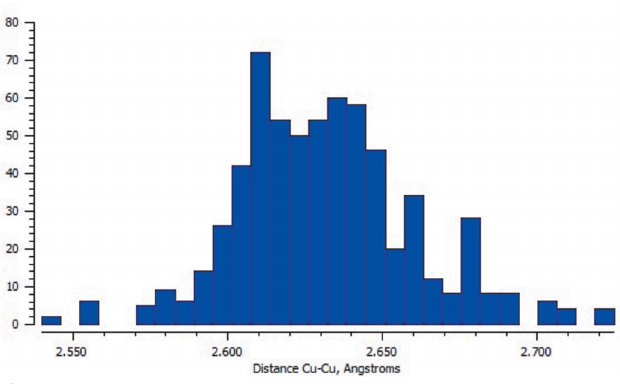
Figure 9 Histogram of the distribution of Cu (cid:3)(cid:3)(cid:3) Cu distances in the Cu 2 (AcO) 4 fragment based on a fragment search in the